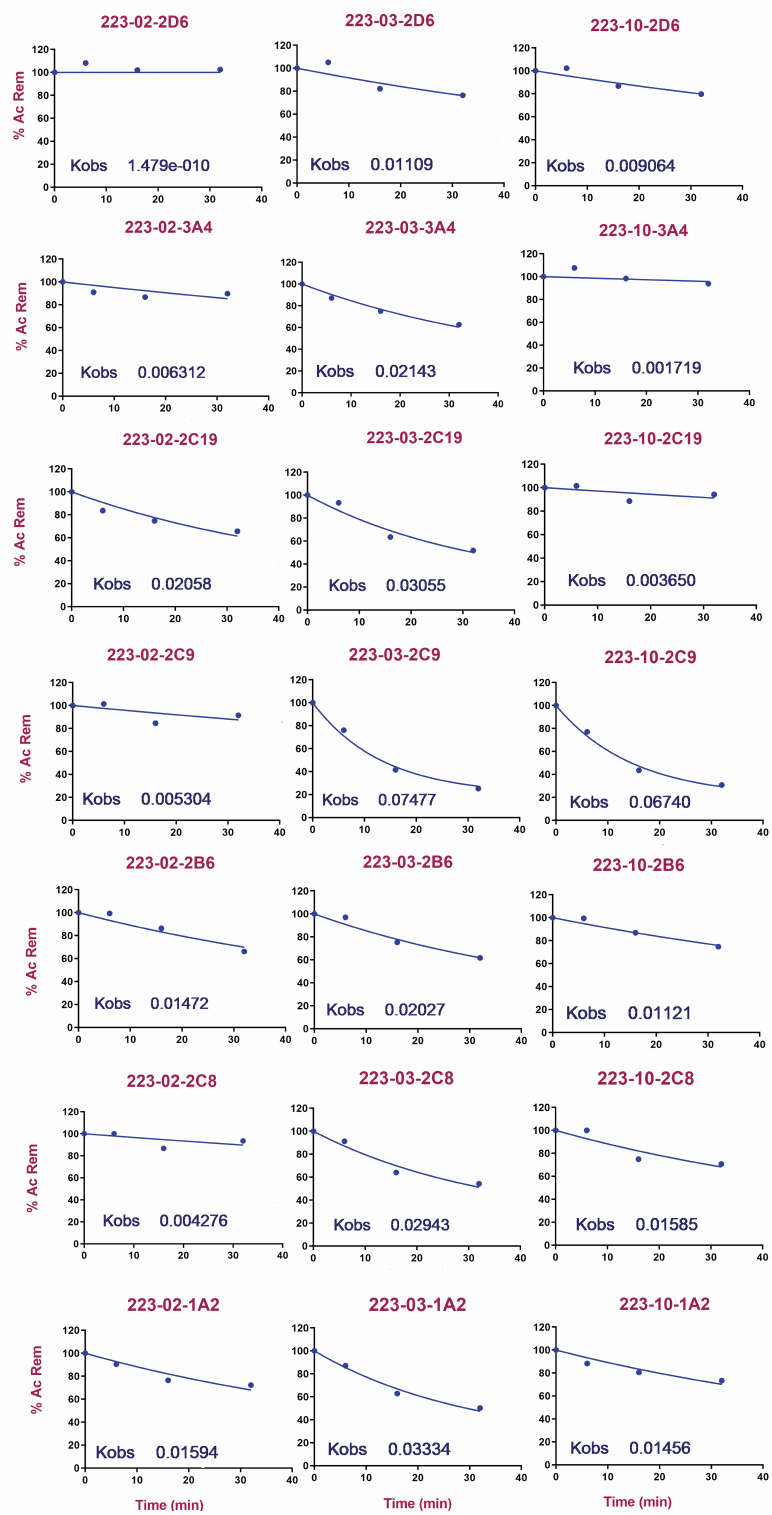
Figure 8. K obs values of TbB ligands with different CYPs. A K obs value of 0.02 min − 1 is a good indicator of TD inhibition potential, and the same is summarized in Table